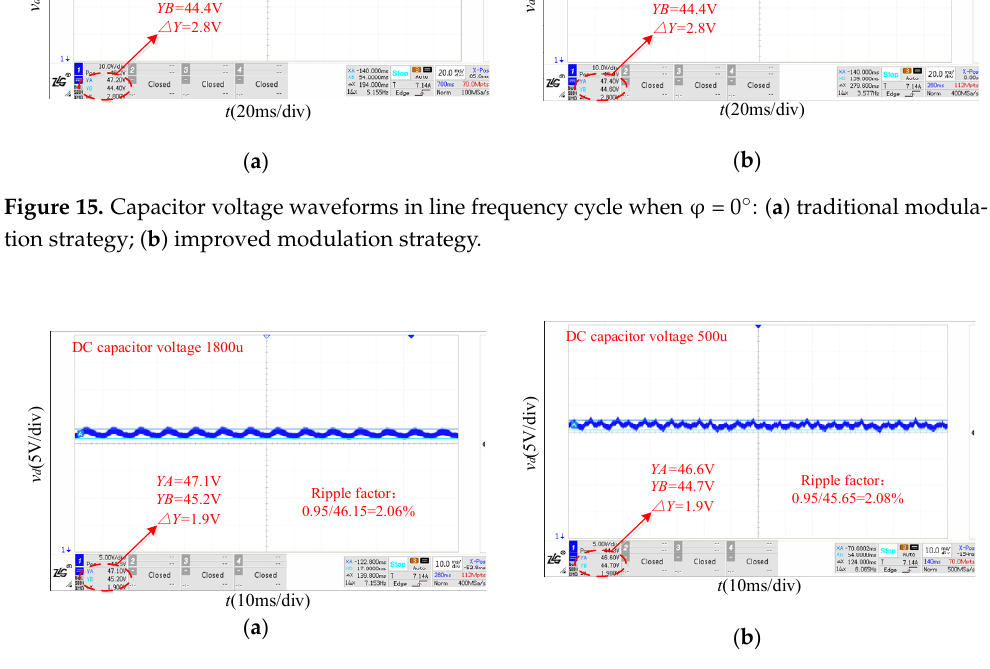
Figure 16. The capacitance voltage waveforms when the voltage ripples are about 2%: ( a ) traditional modulation strategy; ( b ) improved modulation strategy.